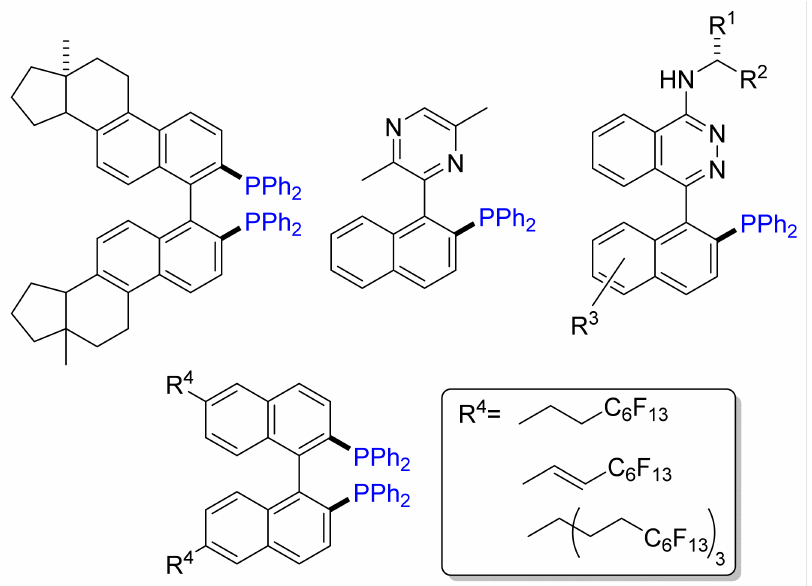
Figure 9. Selected examples of phosphane ligands obtained by Cai’s method.